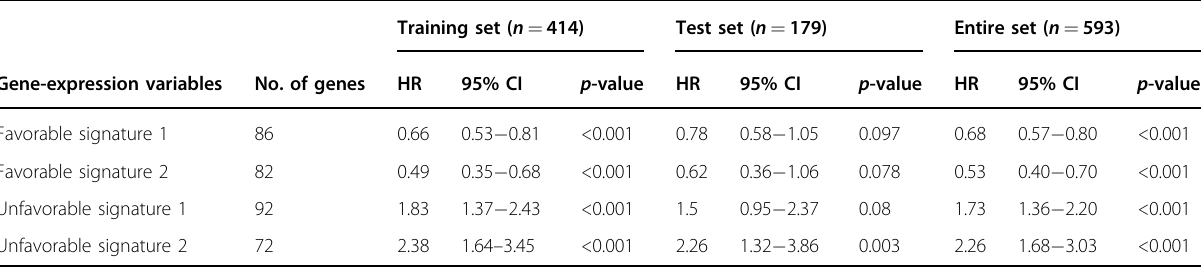
Table 2 Multivariate Cox regression analysis with survival gene signatures for the overall survival of DLBCL